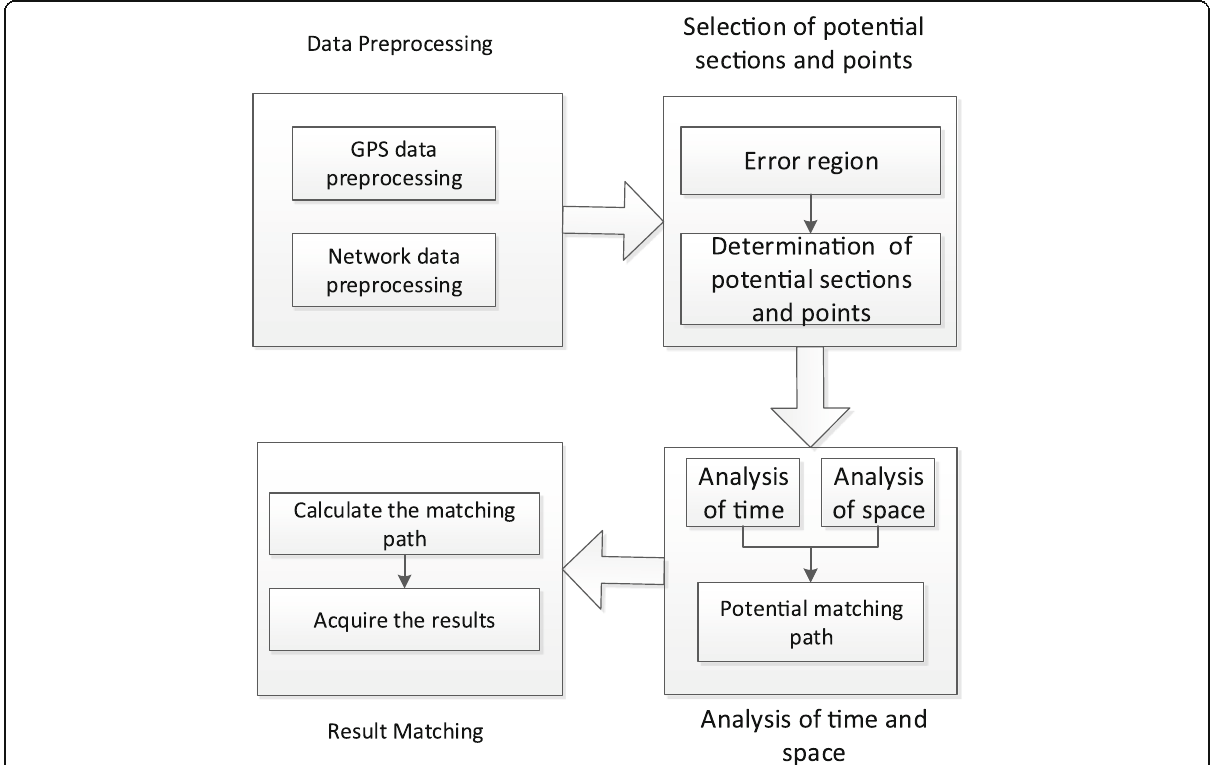
Fig. 1 The framework of map matching